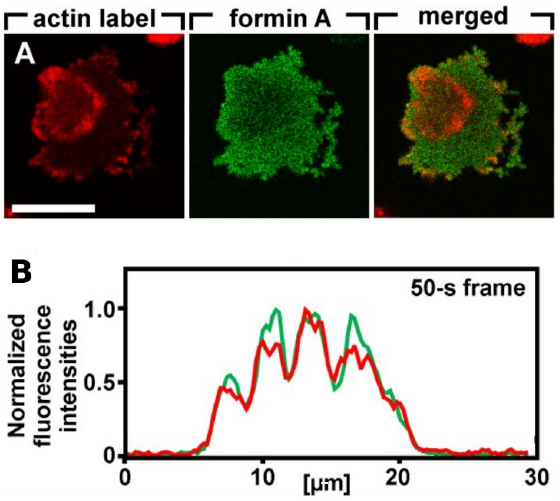
Figure 8. ( A ) Individual and overlay images of actin and formin A in a cell recovering from treatment with 5 µ M latrunculin, showing actin and formins on the substrate-attached cell surface. Scale bar 10 µ m. ( B ) The spatial distribution of formin (green) and Arp2/3 (red) along the wavefront. From Ecke et al.